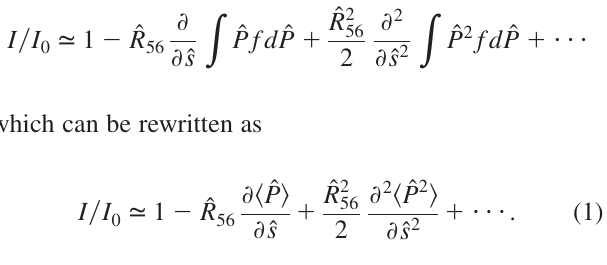
FIG. 3. Modulation of current in the electron beam, modified by FEL interaction as shown in Fig. 2, after passing the dispersion ^ R ¼ 0 : 2 (left), ^ R ¼ 1 (middle), and ^ R section with 56 56 ^ R ¼ 0 is shown in dashed for 56